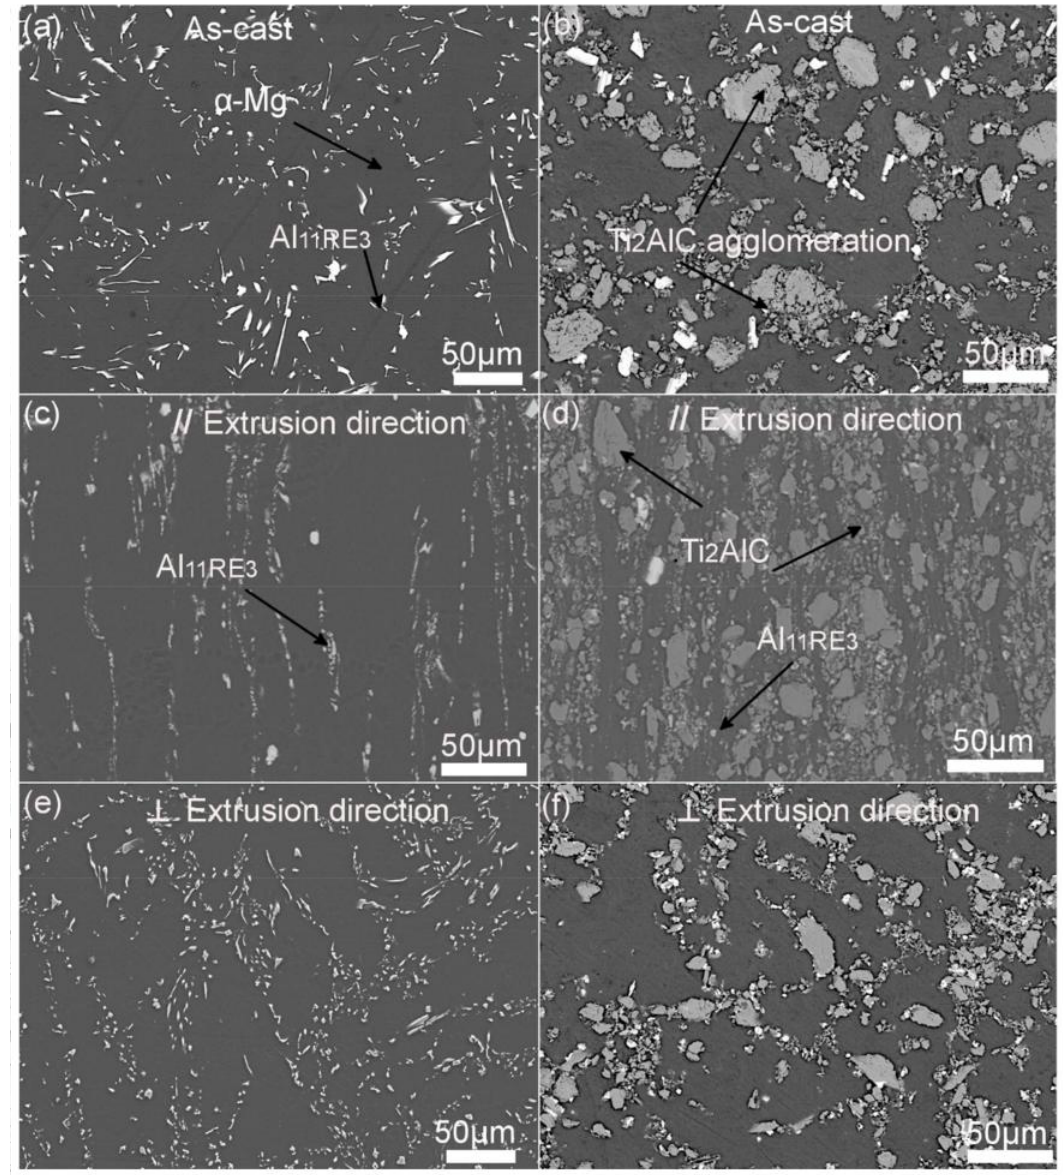
Figure 1. SEM micrographs of AE44 alloys (left column) and 15 vol.% Ti 2 AlC reinforced AE44 composites (right column: ( a ) and ( b ) as-cast, ( c ) and ( d ) // ED(extrusion direction), ( e ) and ( f ) ⊥